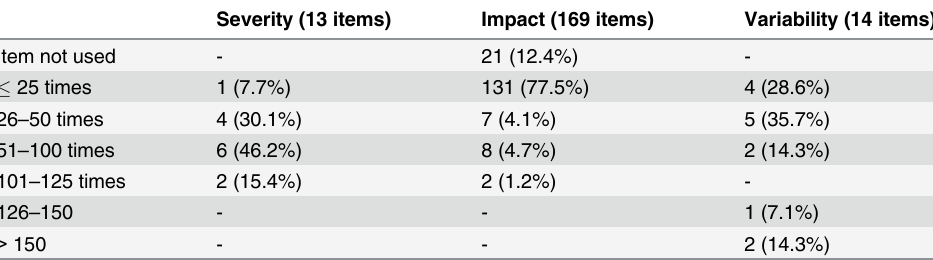
Table 5. Frequency of item usage per CAT dimension in 166 CAT